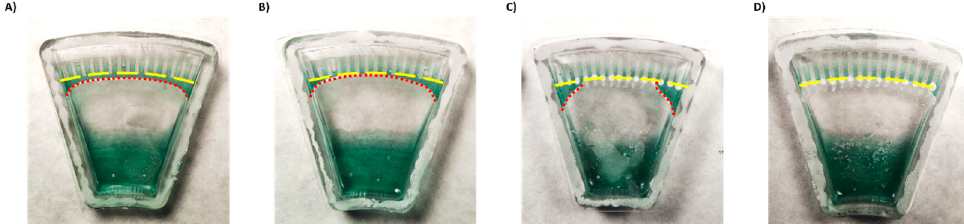
Figure 3. Demonstration of liquid backflow and channel separation after centrifugation of a chip ( A ) without coatings, ( B ) with a hydrophilic coating only, ( C ) with a superhydrophobic coating only, and ( D ) with both hydrophilic and superhydrophobic coatings. Yellow lines indicate channel entrances. Red lines—excess liquid.